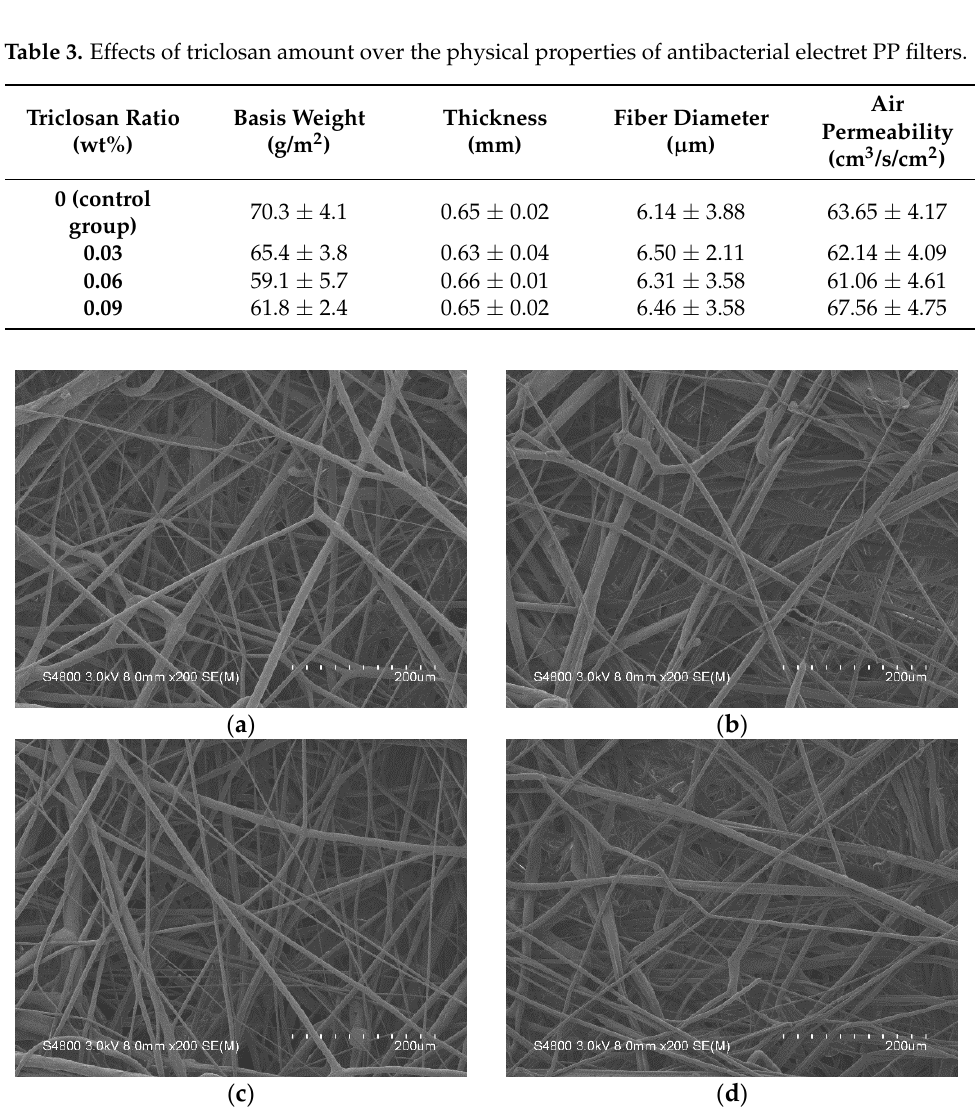
Figure 7. SEM images of antibacterial electret PP filters as related to the triclosan content being ( a ) 0 wt%, ( b ) 0.03%, ( c ) 0.06 wt%, and ( d ) 0.09 wt%.